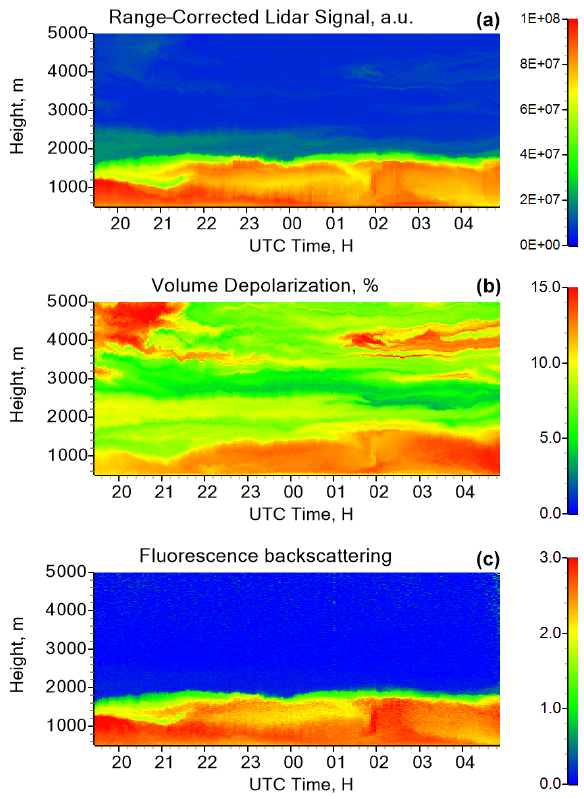
Figure 9. Range-corrected lidar signal at 1064nm (a) , volume depolarization ratio at 1064nm (b) and fluorescence backscatter- ing coefficient (in 10 − 4 Mm − 1 sr − 1 , c ) measured on 27–28 March